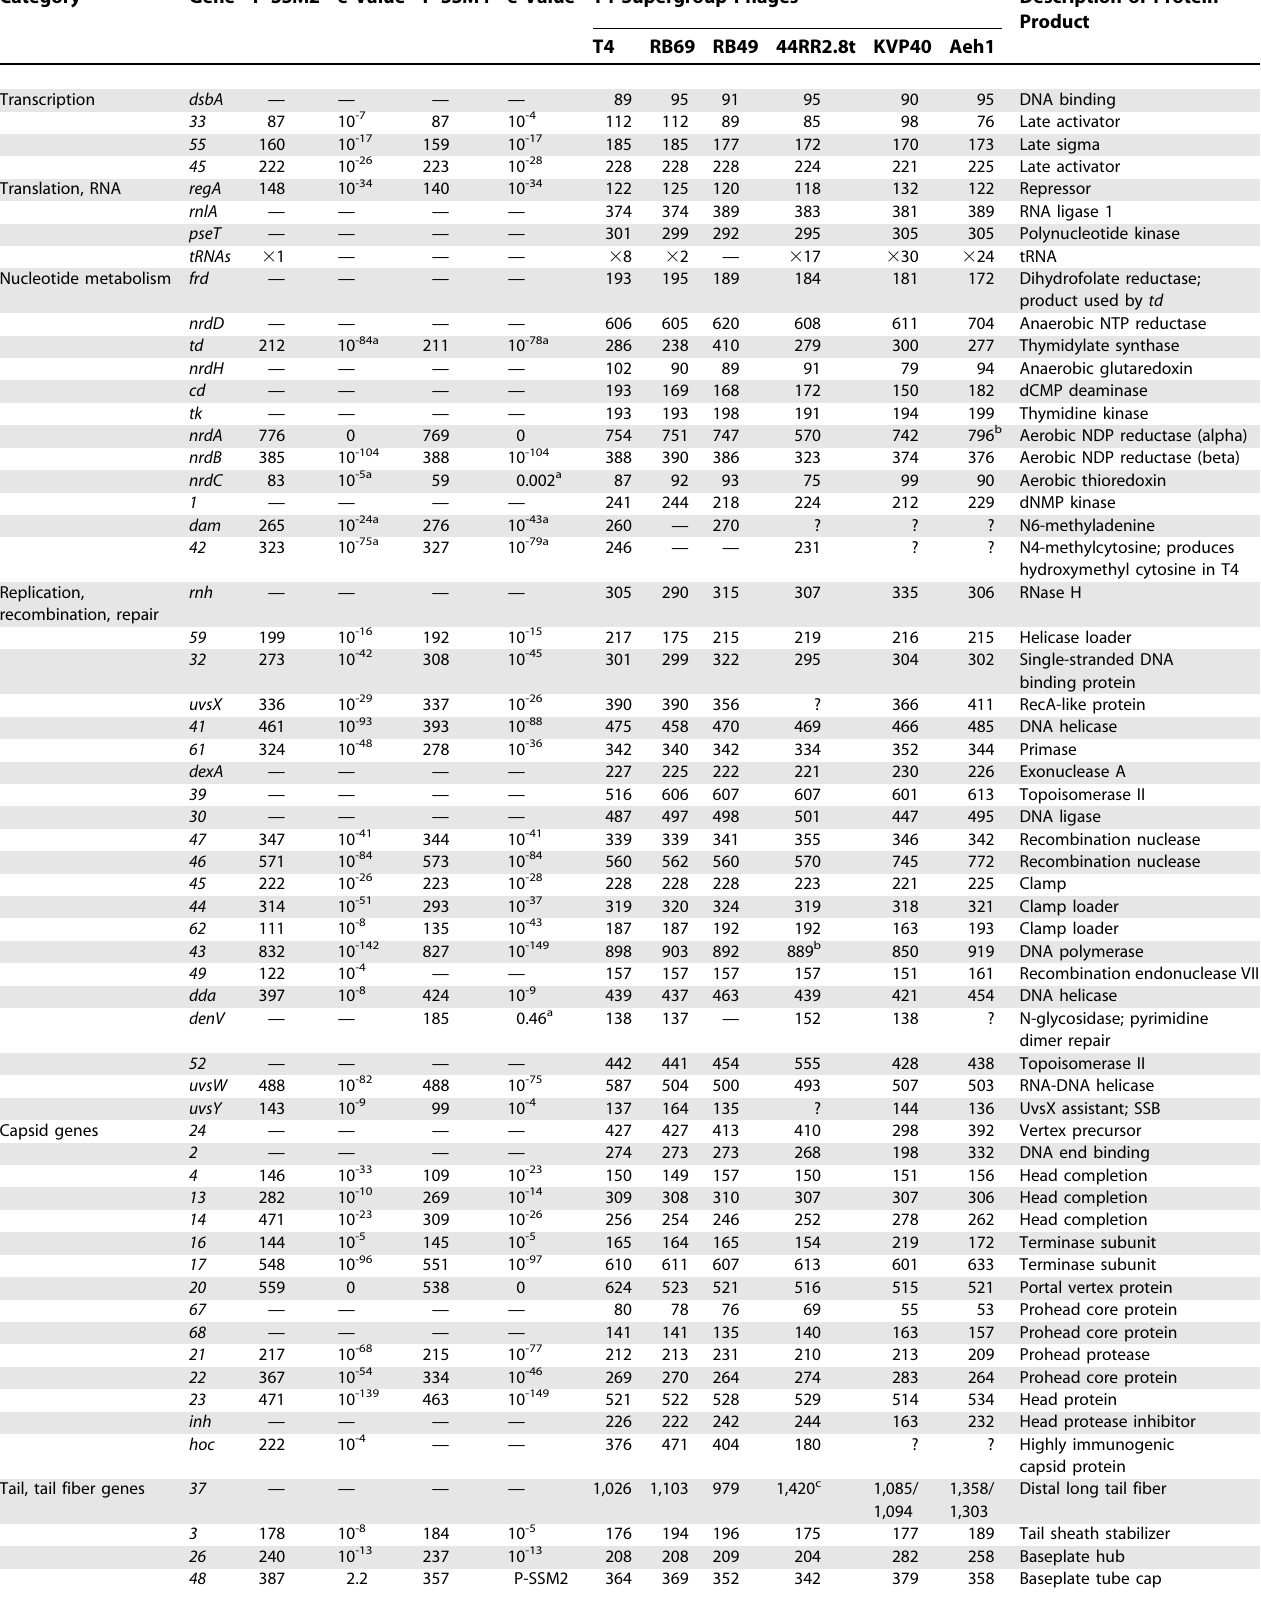
Table 4. Shared Genes in T4-like Phages